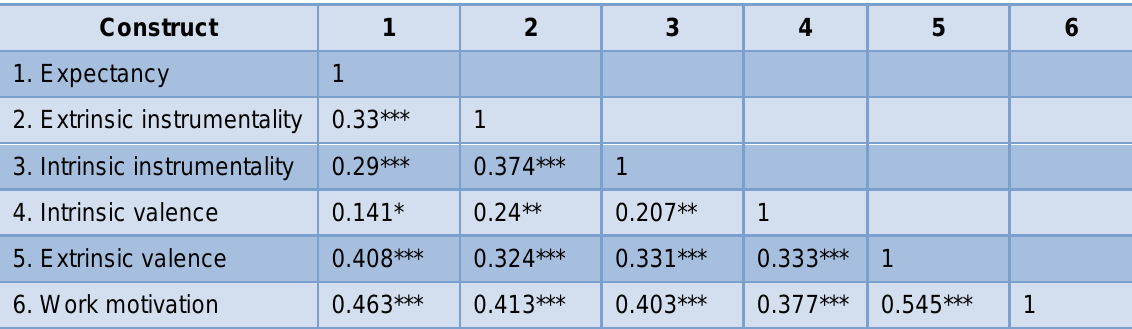
Table 4 Correlations between constructs versus variances extracted